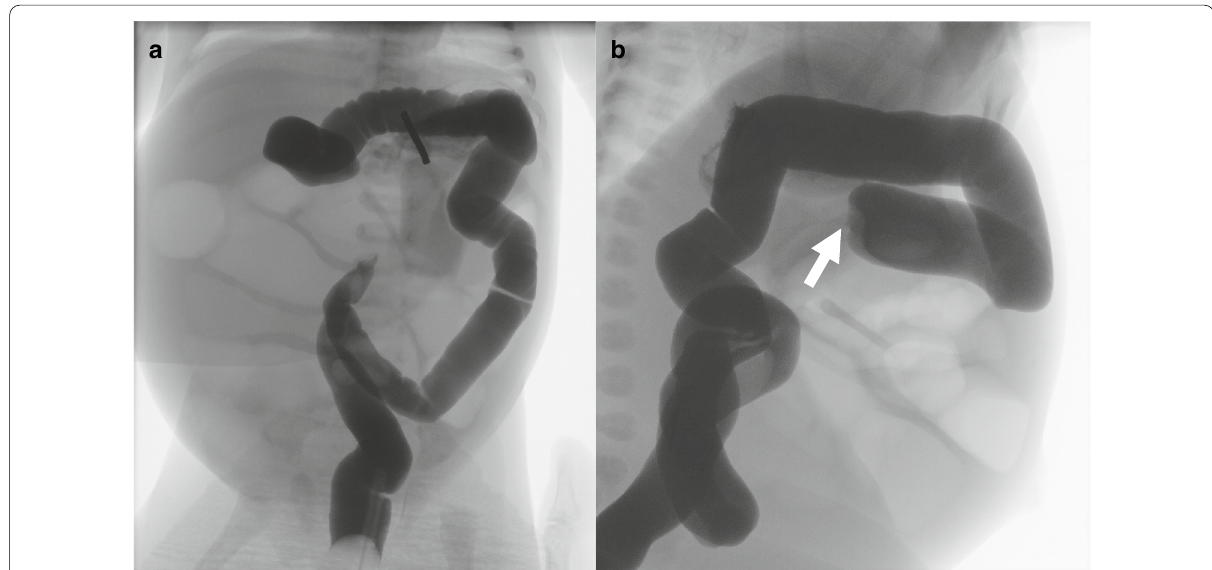
Fig. 1 Preoperative gastrografin enema. a Frontal view. The transverse colon near the hepatic flexure was not delineated on the oral side. b Lateral view. The string sign was observed at transvers colon (white arrow)